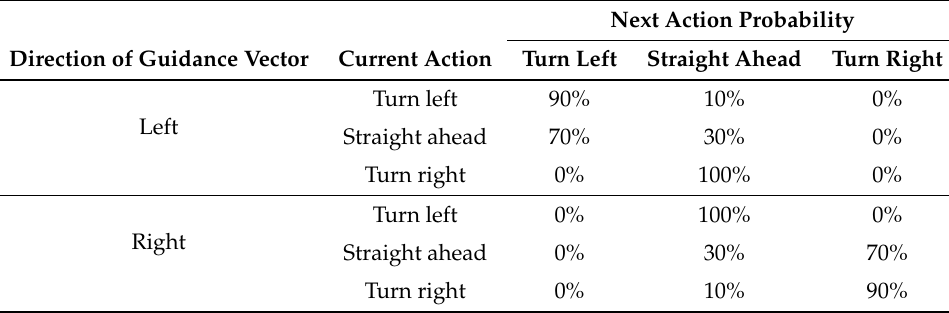
Table 3. UAV action table with direction of guidance